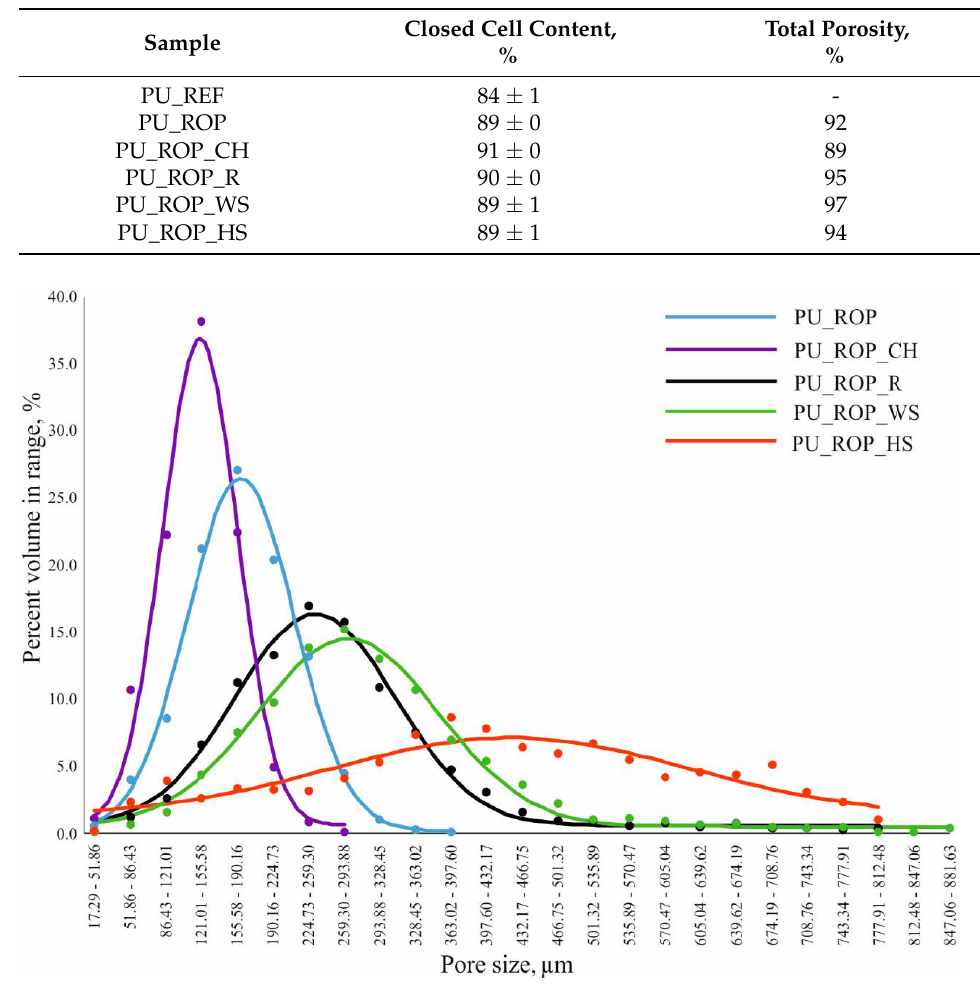
Figure 8. The pore size distribution for PU_ROP and PU_ROP_CH/R/WS/HS